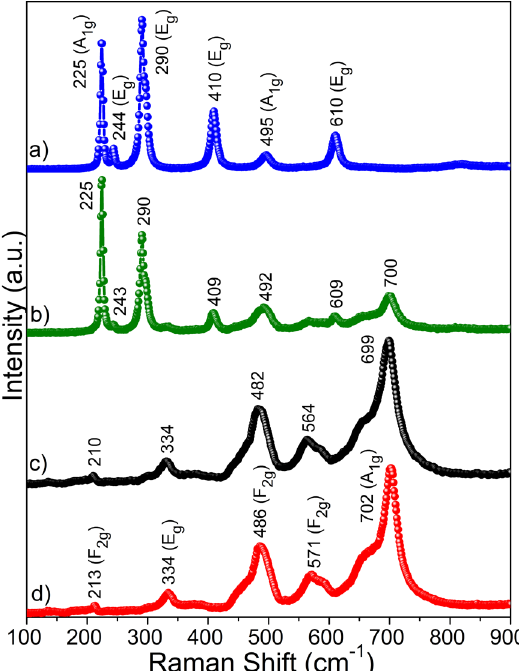
Figure 5. Raman spectra of (a) the initial mixture of reactants and of the samples submitted to heat treatments at (b) 1000 ºC, (c) 1100 ºC and (d) 1200 ºC. The positions of the Raman bands and the corresponding symmetric representations were indicated in the spectra.